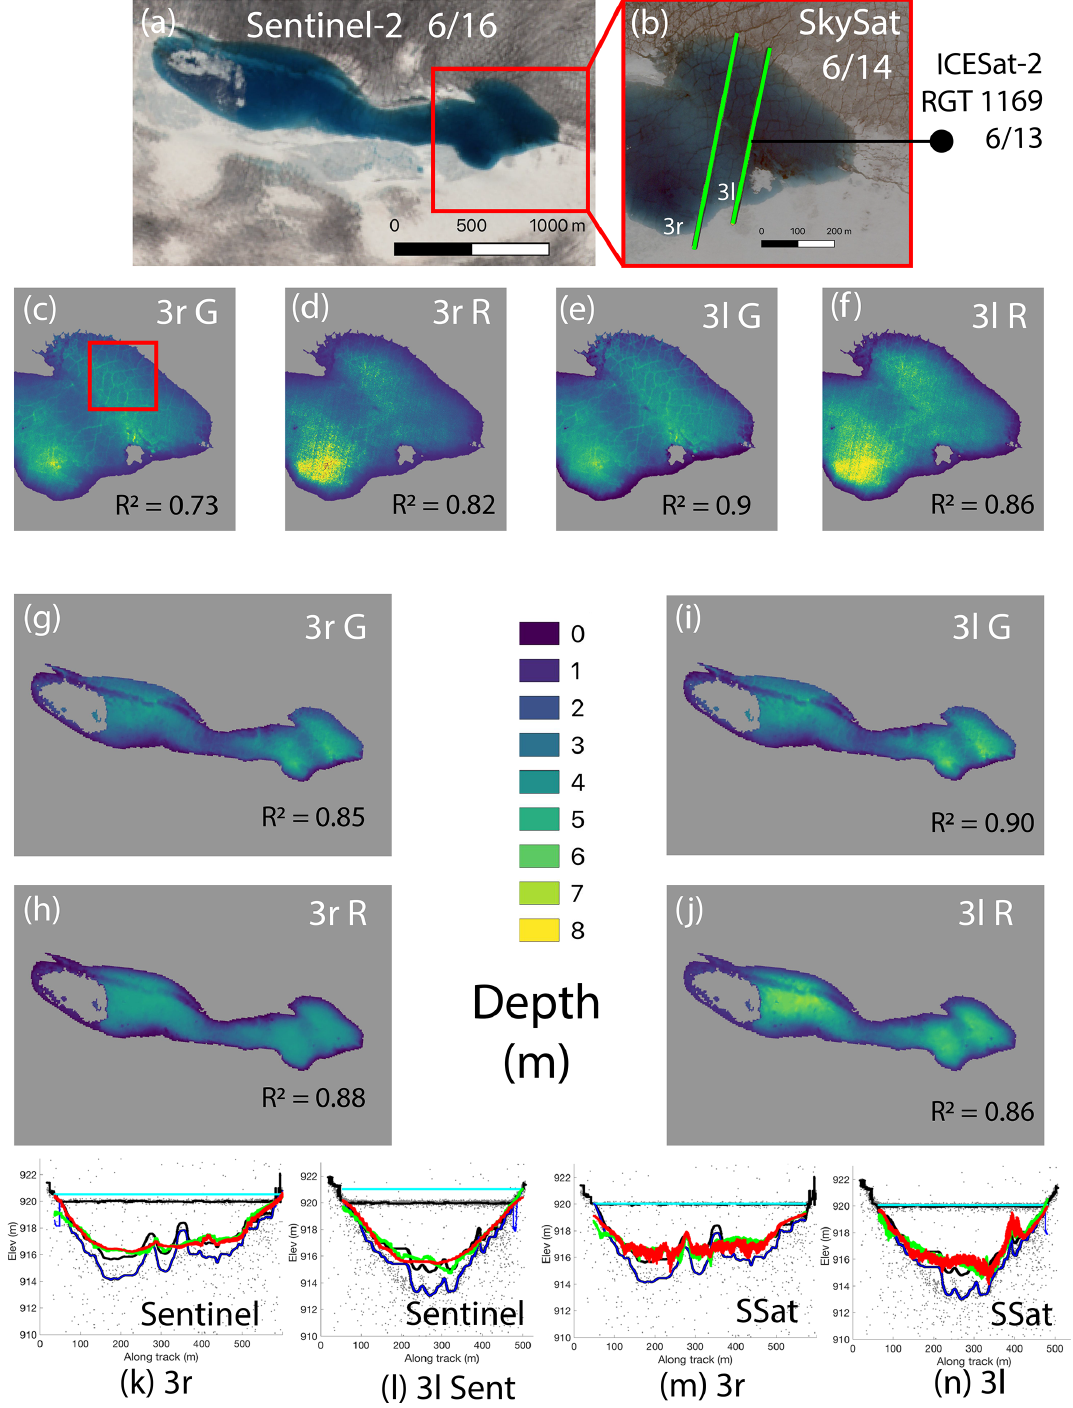
Figure 5. Watta-calculated and imagery-derived depths: Lake Cecily based on Sentinel-2 (k, l) and Planet SkySat (m, n) ; Lake Cecily false- color imagery from Sentinel-2 (a) and SkySat with ICESat-2 beam 3r and 3l (b) ; imagery-derived depths from Planet SkySat (c–f) and Sentinel-2 (g–j) with band–beam combination as shown. Estimates from the green band are indicated by “G”, while those calculated from the red band are indicated by “R”. The red box in (c) highlights region where underlying crevassing is captured.